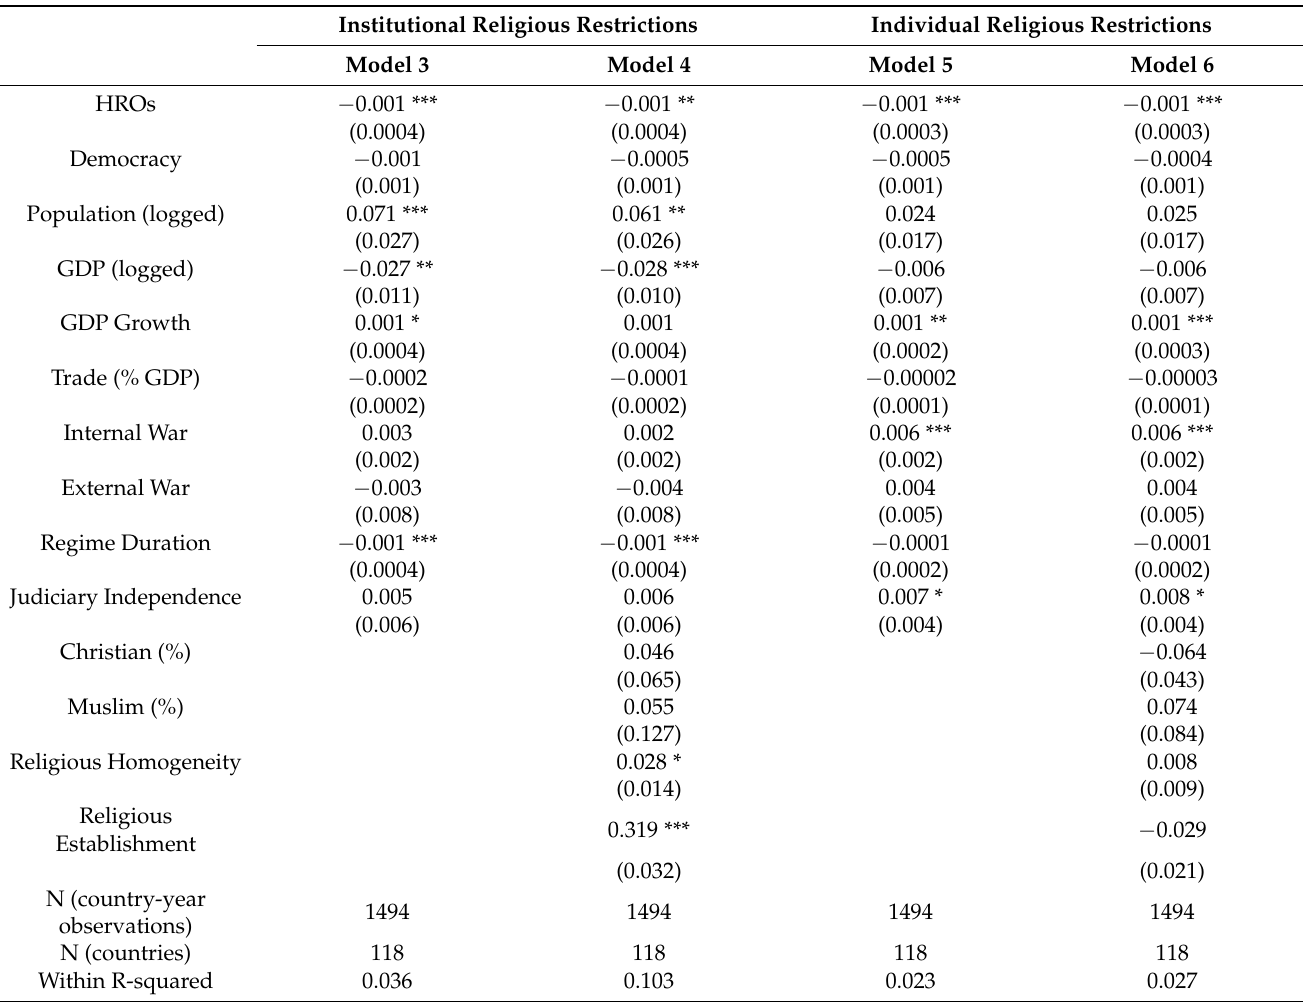
Table 4. The Effect of Domestic Presence of HROs on Institutional and Individual Religious